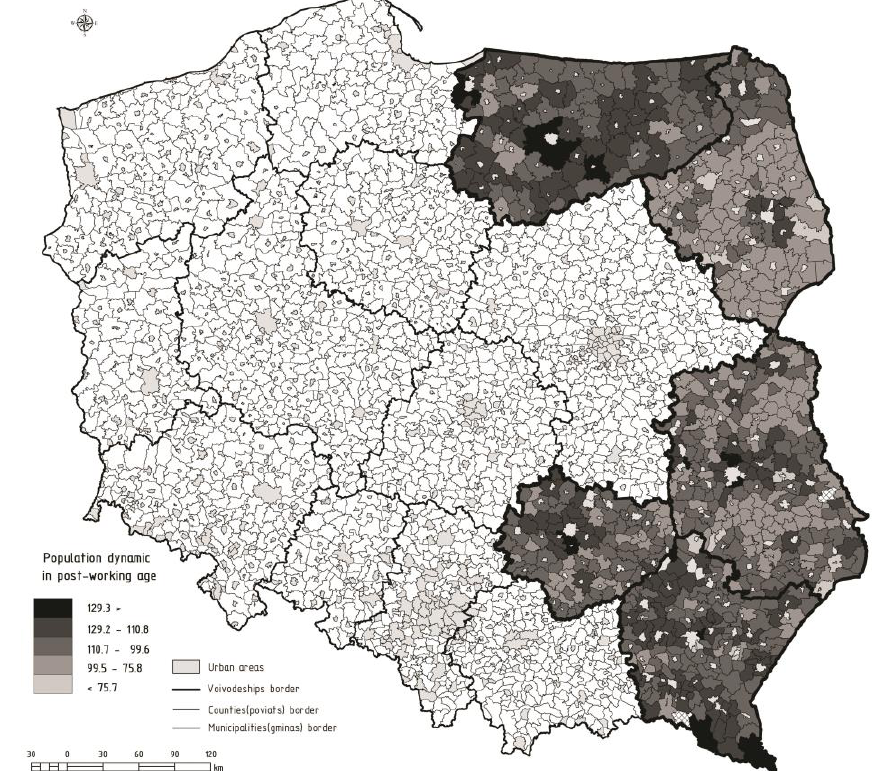
Fig. 6. Dynamic index for the post-working age population in rural areas of Eastern Poland in the period 2008-2020 (Source: calculations of the